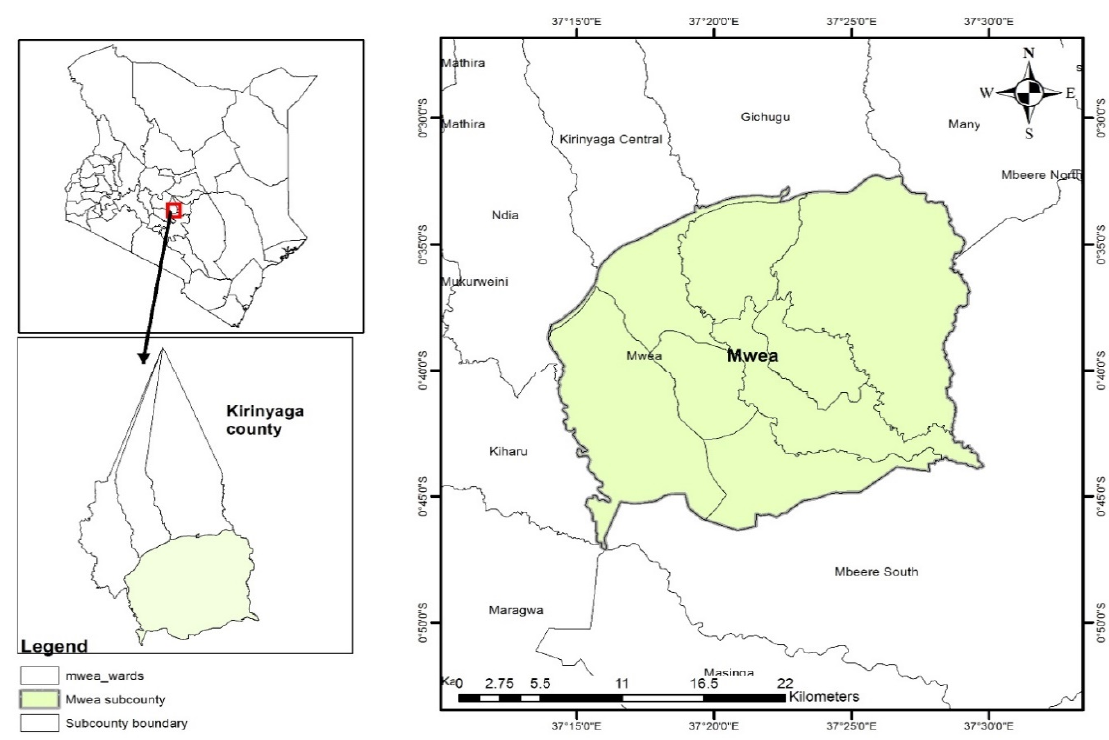
Figure 1. Map of Kenya showing the study area.